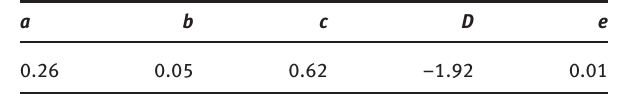
Table 15: Fit results of f 3 ð _ ε , T Þ of BR1500HS steel.